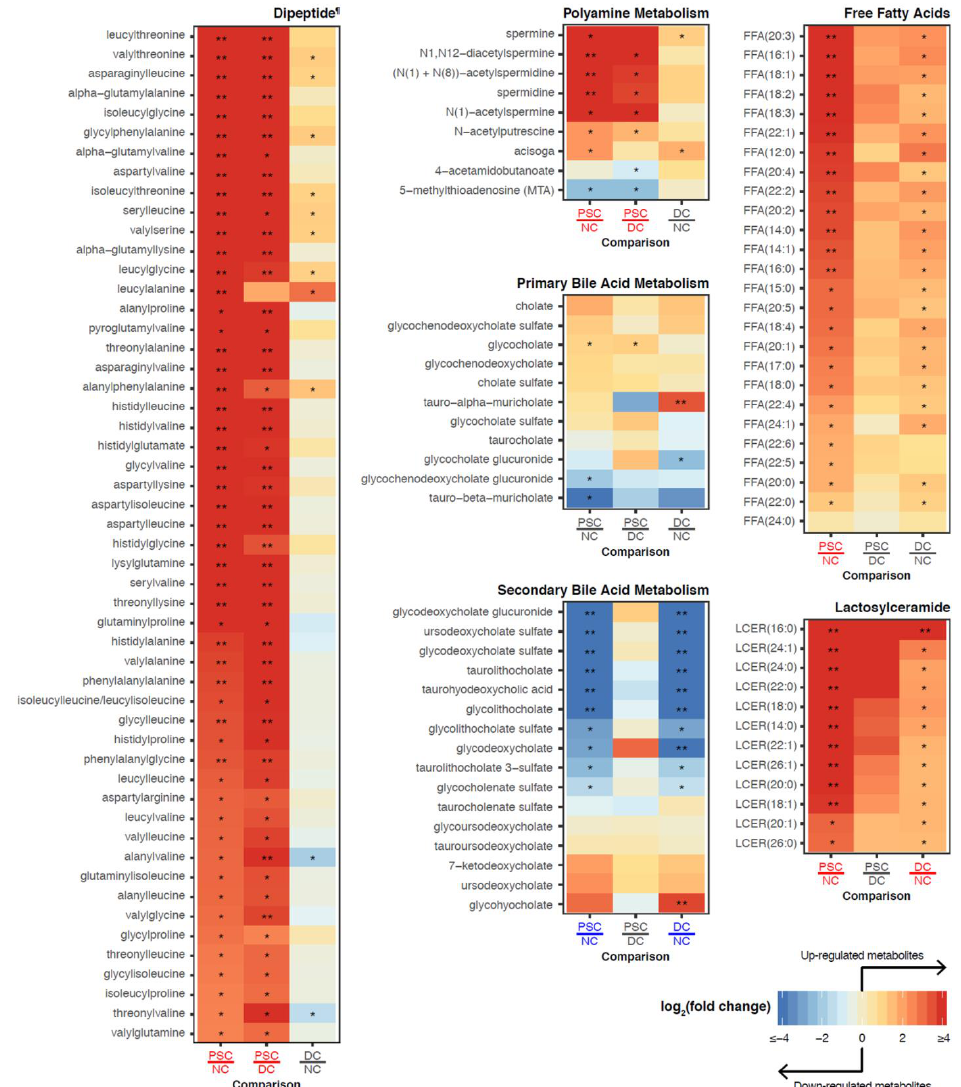
Figure 6. Heatmaps showing fold changes of individual metabolites from bile belonging to subpathways of interest. Labels for phenotype comparisons were colored according to the metabolite set enrichment analysis results. Specifically, a label is colored red (blue) if the subpathway is significantly enriched with upregulated (downregulated) metabolites for the comparison. Metabolites that passed our thresholds for differential abundance were marked with a single asterisk (FC > 2 and FDR < 0.1) or double asterisks (FC > 10 and FDR < 0.01). ¶ Due to the large size of this group, some dipeptides with smaller fold changes are not shown in this figure. For the full heatmap of all dipeptides, see Figure S2.